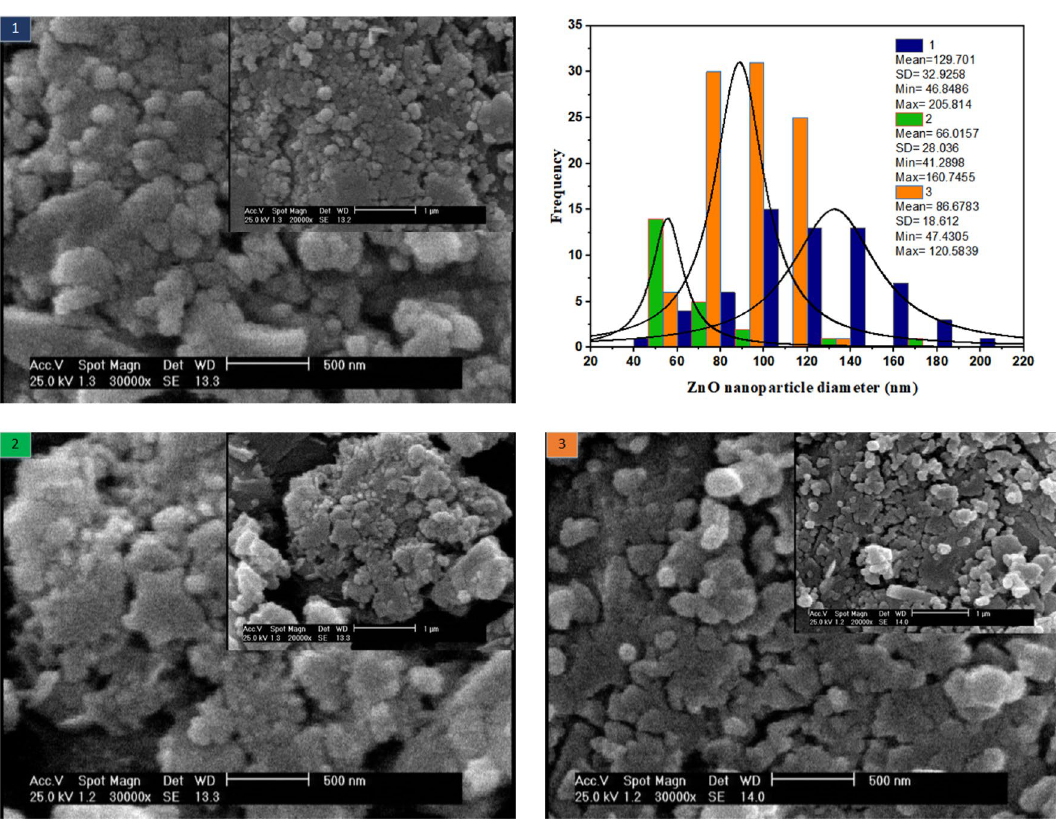
Figure 8. Effect of reagents volumetric flowrate on the morphology of ZnO nanoparticles room temperature synthesis in spiral